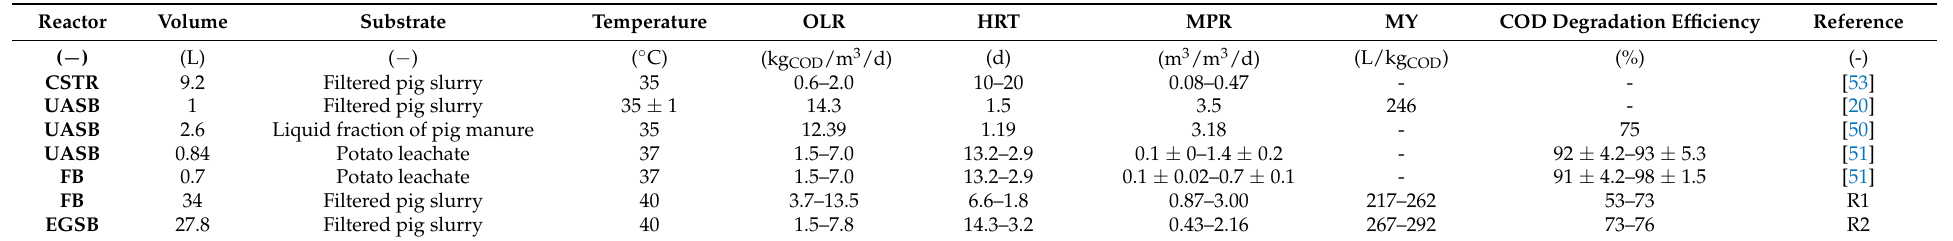
Table 4. Process performance and methane potential of different reactor configurations and